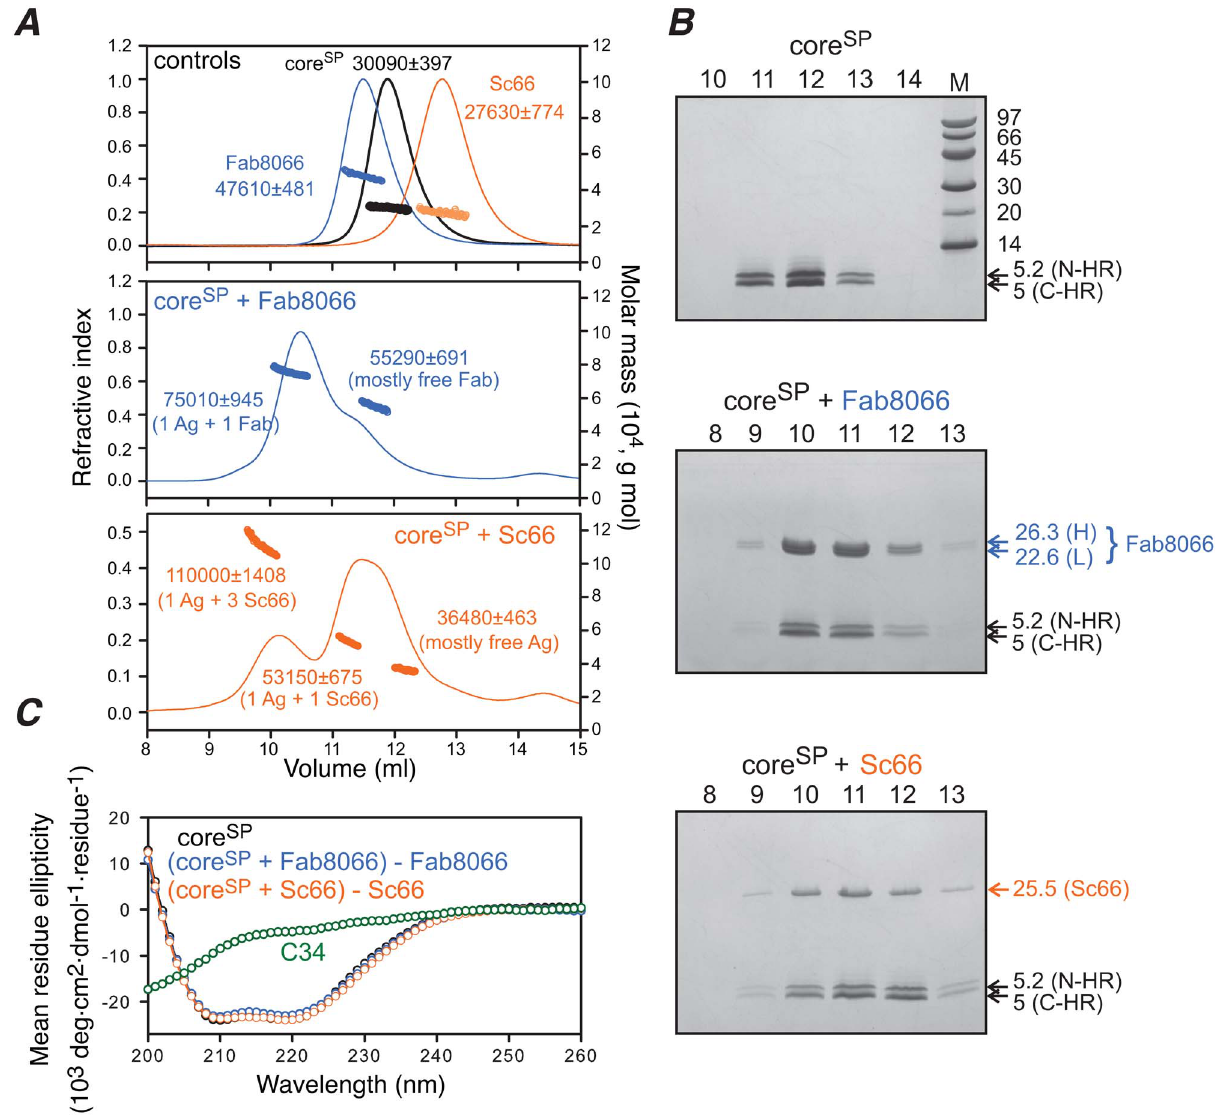
Figure 4. Mass, SDS-PAGE and CD analyses of core SP -antibody complexes. ( A ) SEC-MALS of core SP (black), Fab8066 (blue) and Sc66 (orange) (top) and of the core SP -Fab8066 (middle) and core SP -Sc66 (bottom) complexes (mixed at a molar ratio of 1:1 six-helix bundle to antibody). Average masses and compositions are indicated next to the peaks. ( B ) SDS-PAGE of peak fractions (numbering of lanes corresponds to elution volume) collected from SEC-MALS confirm the composition of the peaks indicated on the SEC-MALS traces in panel A. Top, core SP alone; middle, core SP + Fab8066 (H and L denote heavy and light chains, respectively); bottom, core SP + Sc66. ( C ) CD of core SP alone (black); a 1:1 mixture of (core SP + Fab8066) minus Fab8066 alone (blue); a 1:1 mixture of (core SP + Sc66) minus Sc66 alone (orange); and the C34 peptide (green, corresponding to the C-HR) alone. The CD data indicate that there is no change in helicity of core SP when complexed to either Fab8066 or Sc66. doi:10.1371/journal.pone.0104683.g004 panel). The same 1:1 mixture elutes as a single peak on SEC-MALS corresponding to a combined mass of 1 core S timer + 1 Fab8066 ( , 73 kDa), with a very small shoulder, corresponding to free Fab8066 ( , 53 kDa). Addition of more Fab8066 at 1:2 and 1:3 core S :Fab ratios does not result in the binding of additional Fab8066 molecules to core S , as evidenced by the presence of an excess Fab8066 band in the native-PAGE lanes (Fig. 3A, left panel). A similar 1:1 mixture of core S and Fab8062 barely shows any shift on native-PAGE and elutes on SEC-MALS mainly in free form with masses of , 52 and 26 kDa, corresponding to Fab8062 and core S , respectively (Fig. 3A, right panel, dashed trace).